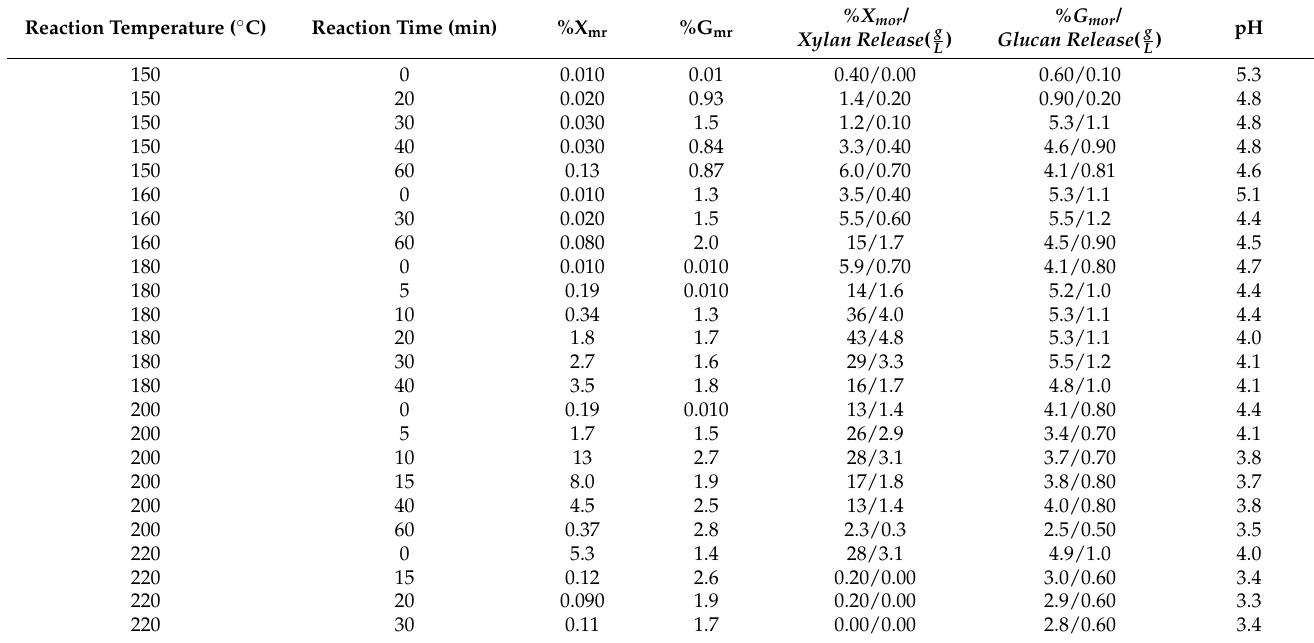
Figure 3. Polymers release to monomers and oligomers of ( a ) xylose (%X mor ) and ( b ) glucose (%G mor ). Data points represent the averages of 3 experiments. Error bars represent standard uncertainties. Table 2. Results of laboratory-scale batch HP experiments.